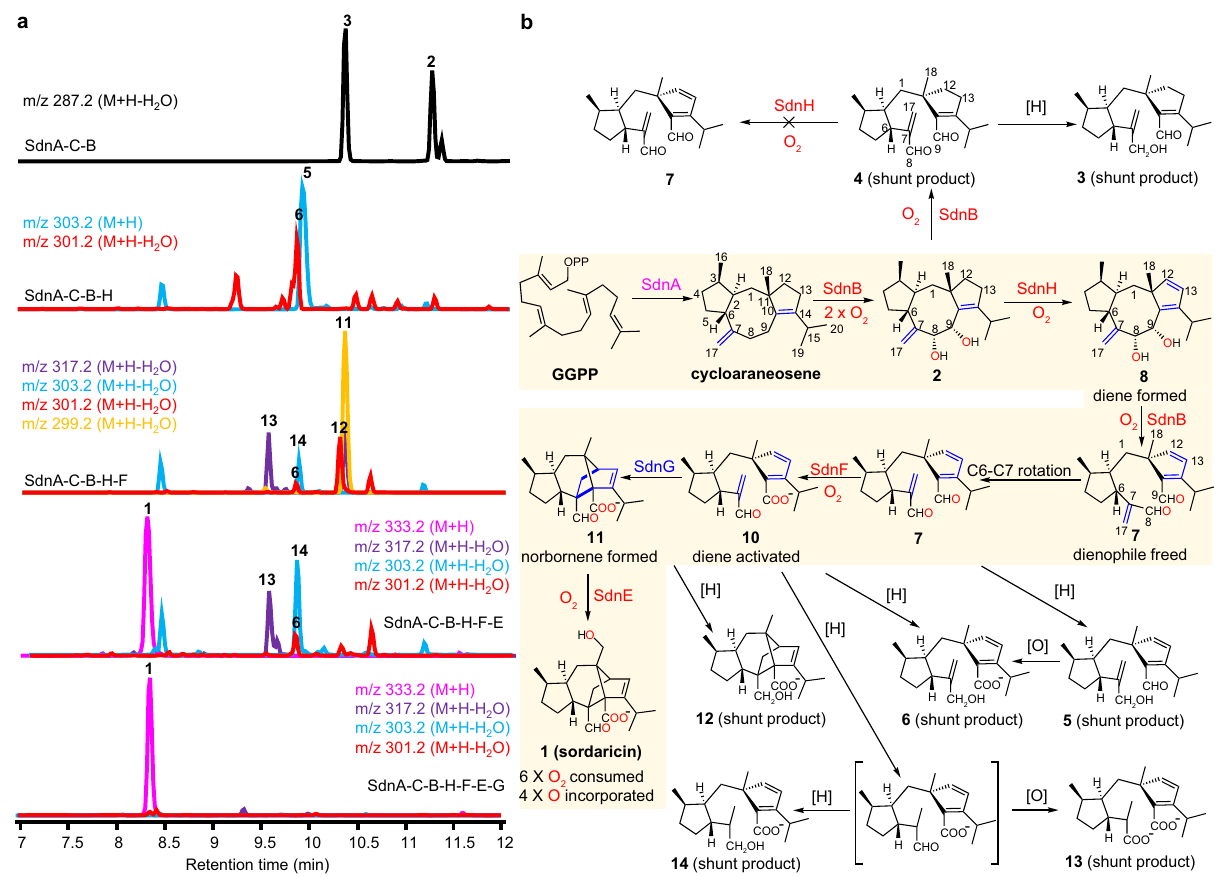
Fig. 2 Sordaricin biosynthesis involves a concise yet well-programed chemical logic. a Stepwise heterologous reconstitution of genes involved in sordaricin biosynthesis. The chromatograms are extracted from mass spectra of the base peak for each compound. b Complete biosynthetic pathway for sordaricin. The main pathway is highlighted with a shaded background. All numbered compounds are structurally characterized via NMR and HRMS. The compound in bracket is proposed but not